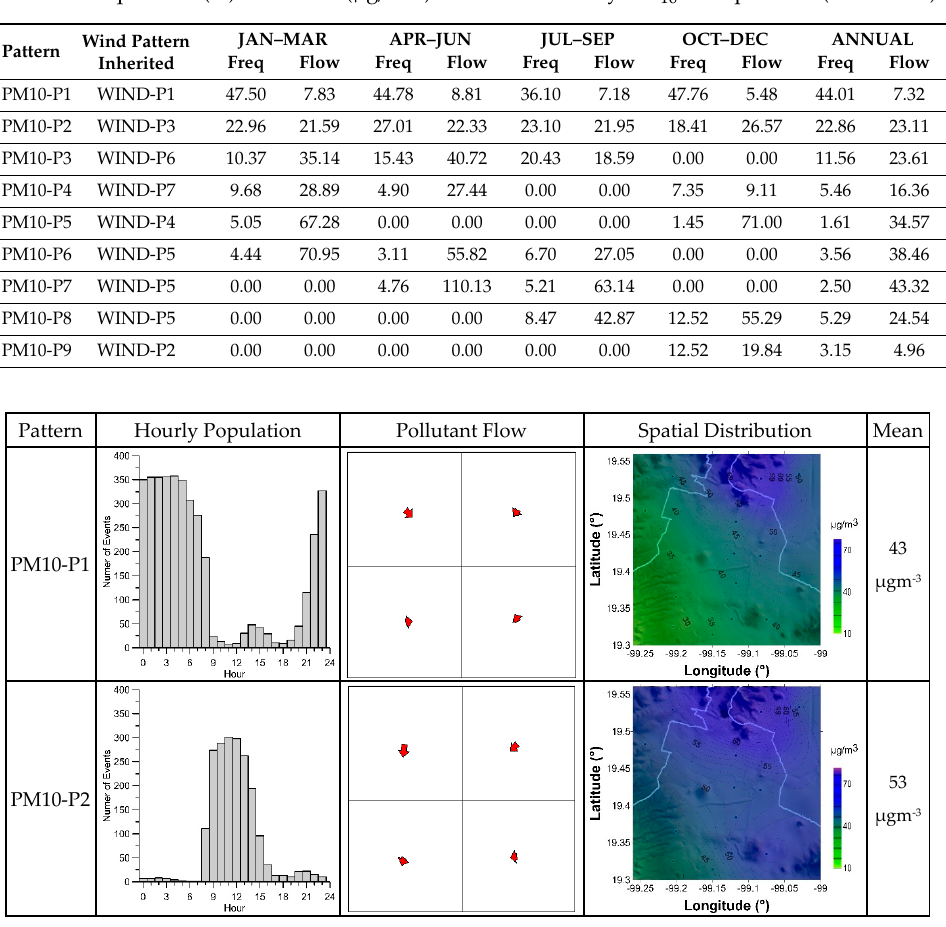
Table 6. Frequencies (%) and flows (µg/m 2 s) of the Mexico City PM 10 flow patterns (2001–2010).